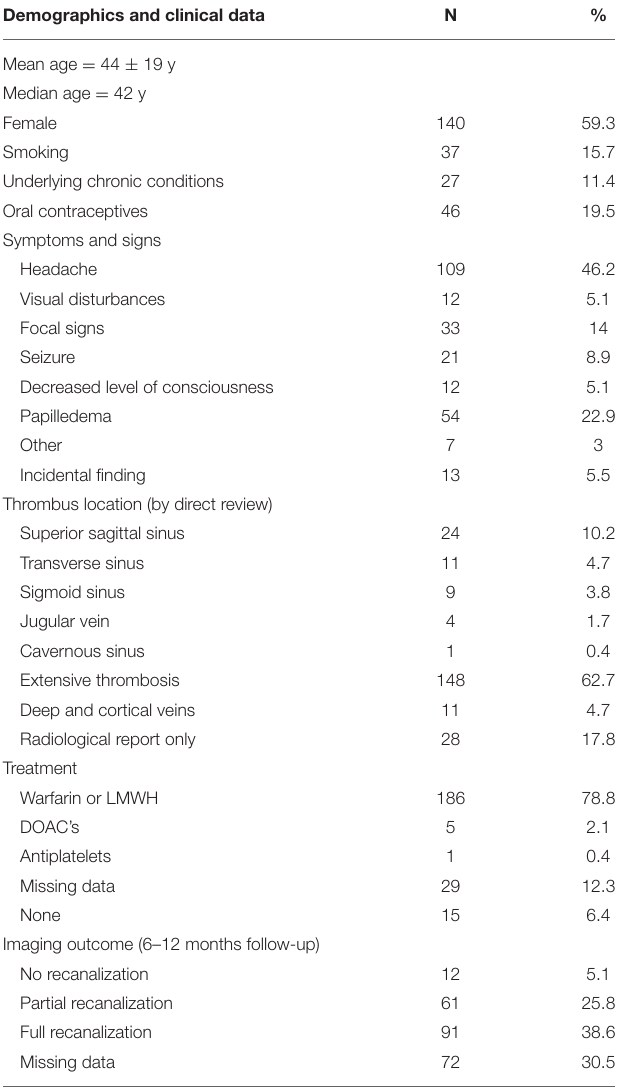
TABLE 1 | Clinical, demographical, and laboratory data of patients with CSVT (% — calculated of total, 236 patients’ cohort). Demographics and clinical